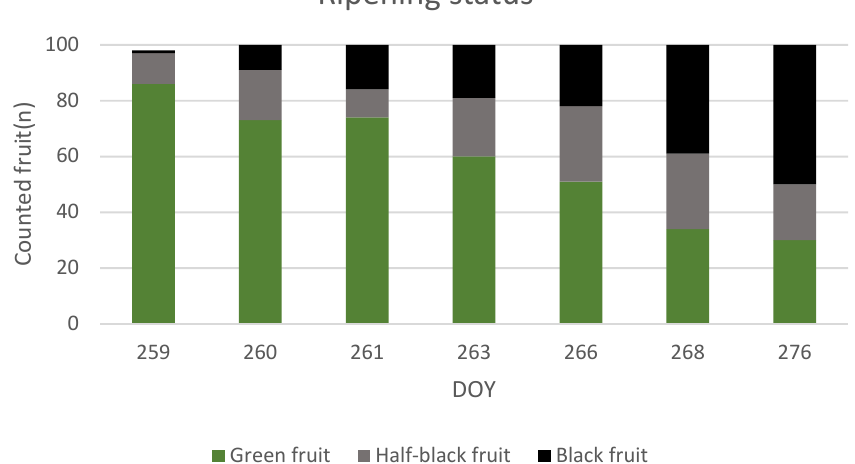
Figure 11. Fruit ripening data extracted from images of time-lapse video.